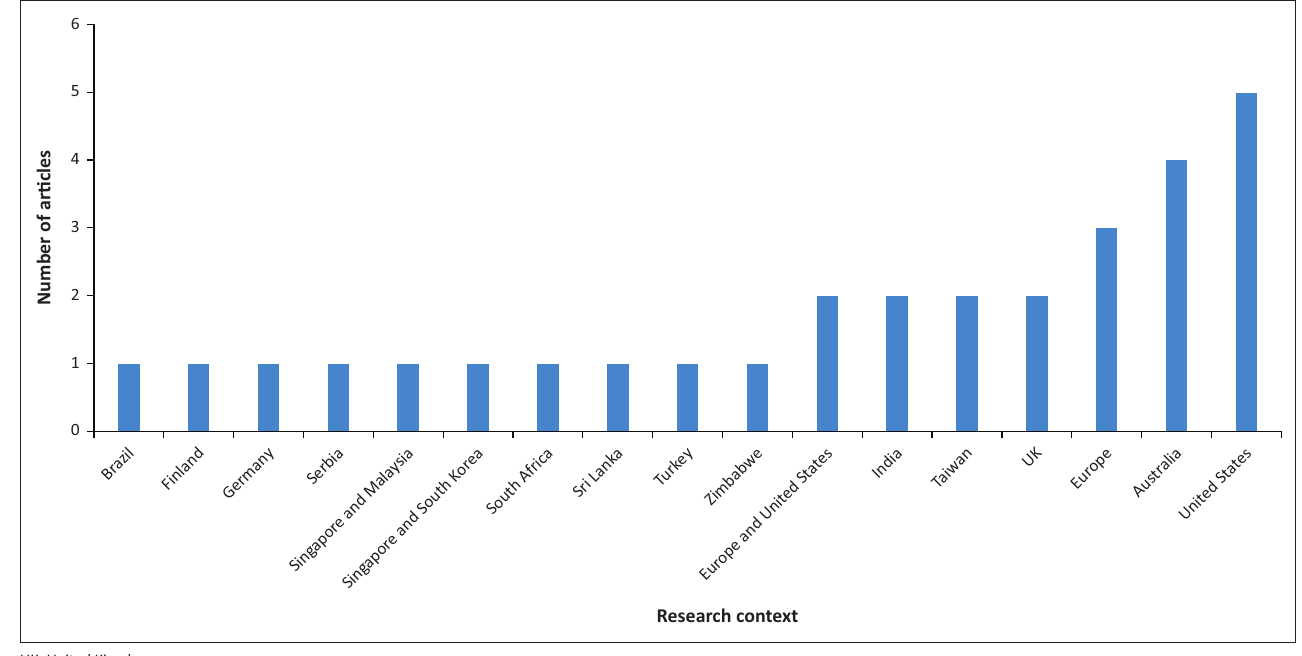
FIG URE 3: Distribution of the number of reviewed articles by research